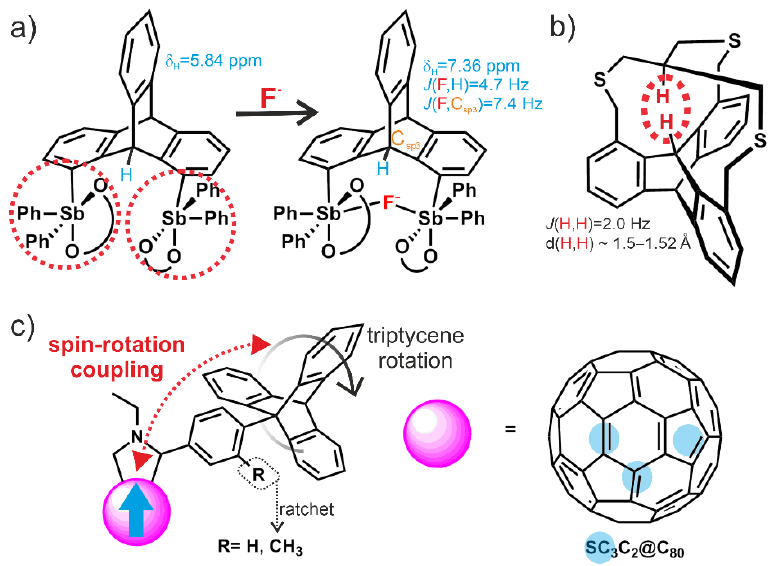
Figure 3. ( a ) A weak interaction between Csp 3 -H and F − is confirmed by the spin–spin coupling constants [158]. ( b ) The congested structure of 1,8,13-tris(mercaptomethyl)triptycene and the interaction between two closely located protons ( c ) The spin-rotation coupling within the triptycene–fullerene-based system [159].